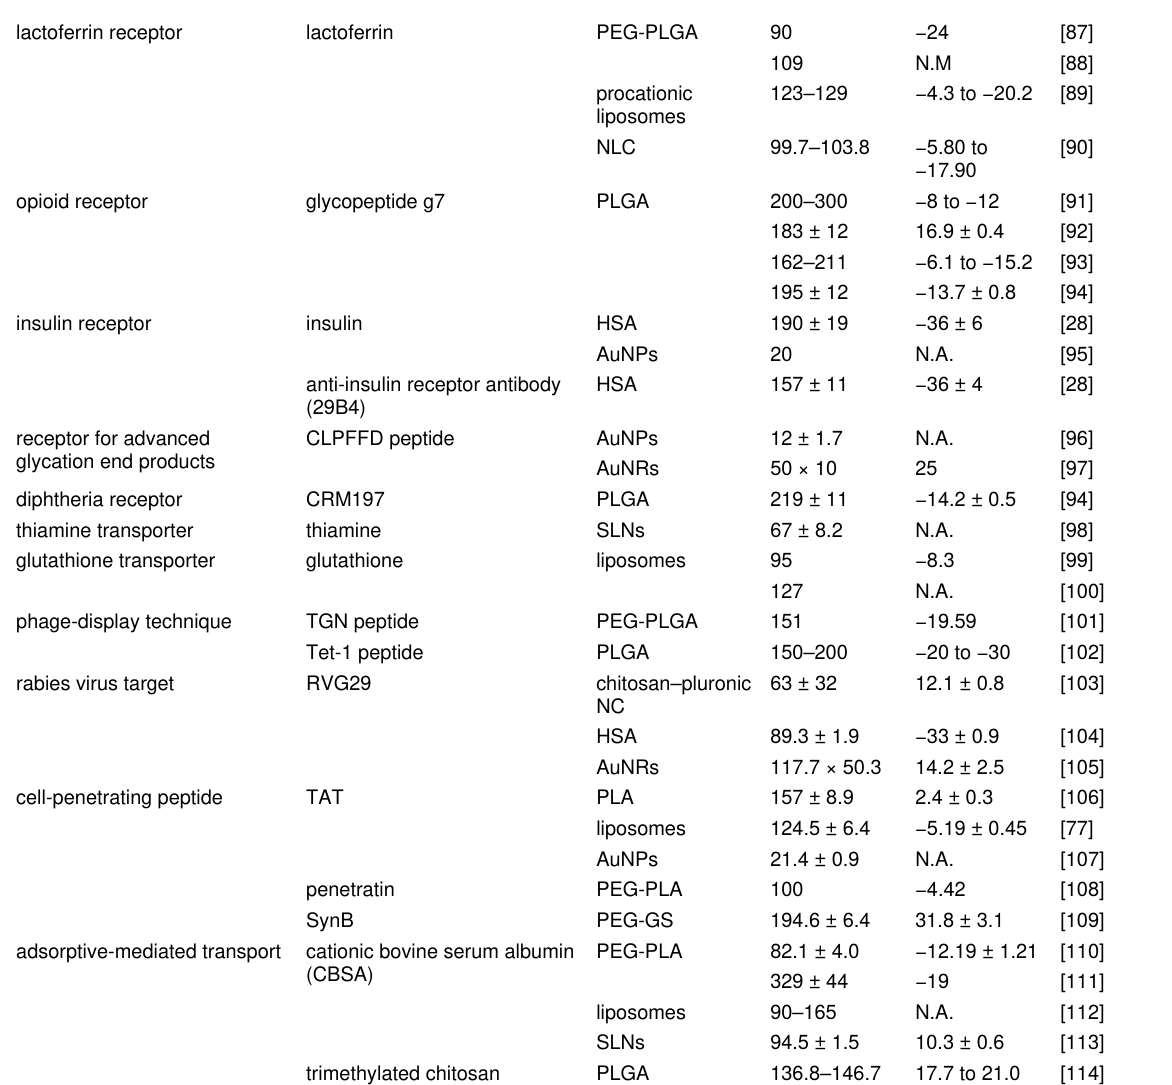
Table 1: Summary of surface functionalization strategies for improved BBB crossing of nanoparticles. a (continued)